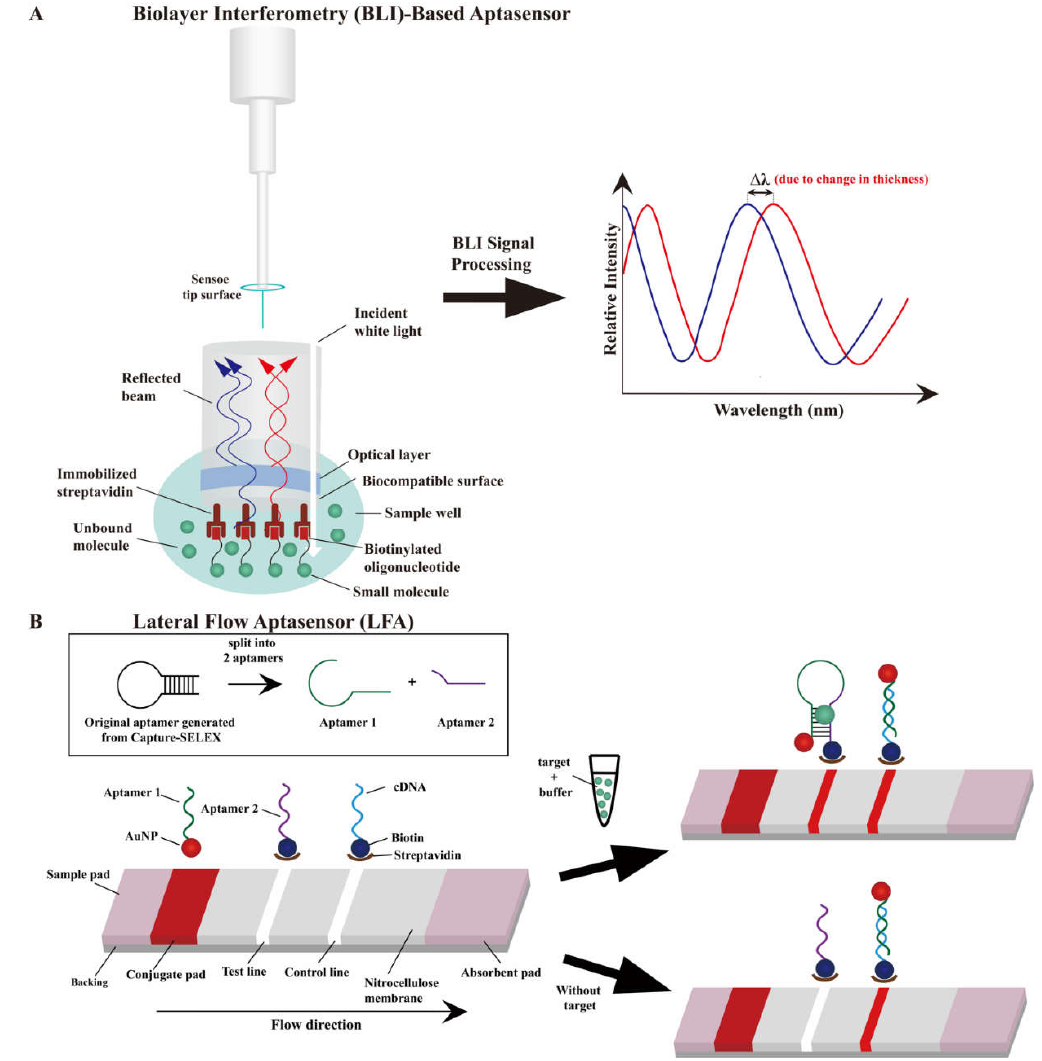
Figure 3. The schematic illustration of aptasensors for the detection of small molecules using novel aptamer generated from Capture-SELEX. ( A ) Biolayer interferometry (BLI)-based aptasensor. ( B ) A lateral flow aptasensor (LFA) is generally constructed by 4 sections: sample pad, conjugate pad, nitrocellulose membrane with test line and control line, and absorbent pad. The sample flow from left to right laterally (left). When the target is loaded onto the sample pad, positive result (red band for both control and test line) is observed after 15 min (right).